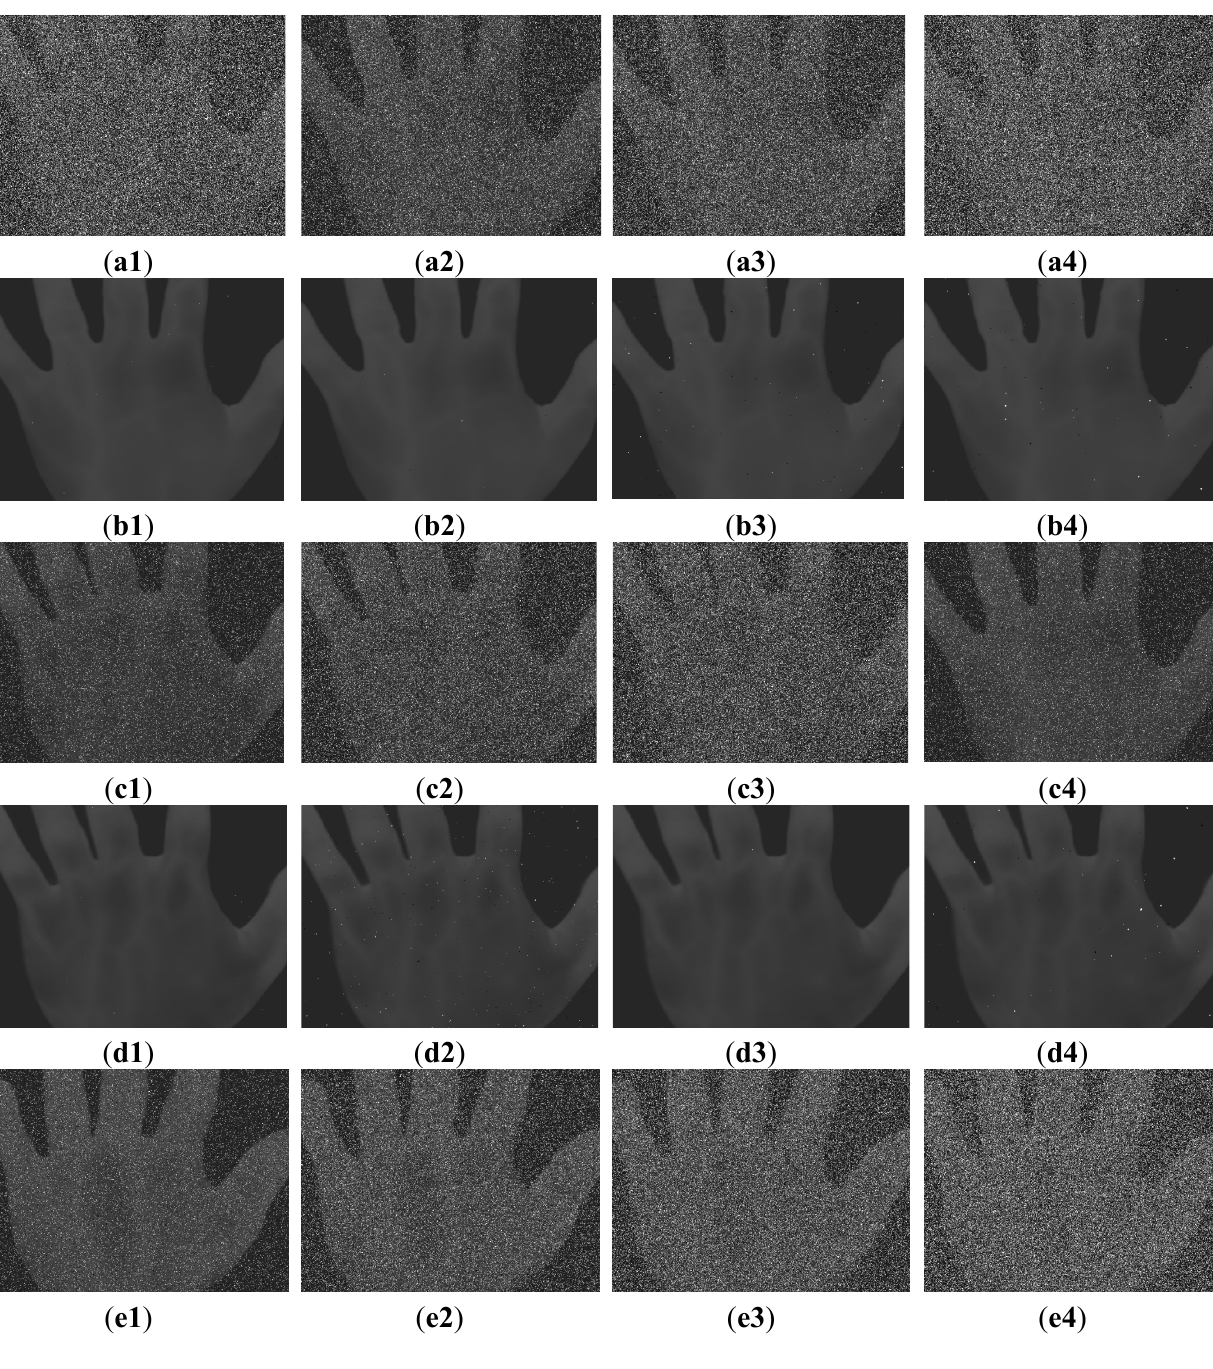
Figure 3. Figure 2(a–d) with impulse noise filtered by FMBF. ( a1 – a4 ) show Figure 2(a) with impulse noise of 10%, 20%, 30% and 40%, respectively; ( b1 – b4 ) show the results of (a1–a4) filtered by FMBF once, once, two times and three times, respectively; ( c1 – c4 ) show Figure 2(b) with impulse noise of 10%, 20%, 30% and 40%, respectively; ( d1 – d4 ) show the results of (c1–c4) filtered by FMBF once, once, two times and three times, respectively; ( e1 – e4 ) show Figure 2(c) with impulse noise of 10%, 20%, 30% and 40%, respectively; ( f1 – f4 ) show the results of (e1–e4) filtered by FMBF once, once, two times and three times, respectively; ( g1 – g4 ) show Figure 2(d) with impulse noise of 10%, 20%, 30% and 40%, respectively; ( h1 – h4 ) show the results of (g1–g4) filtered by FMBF once, once, two times and three times,